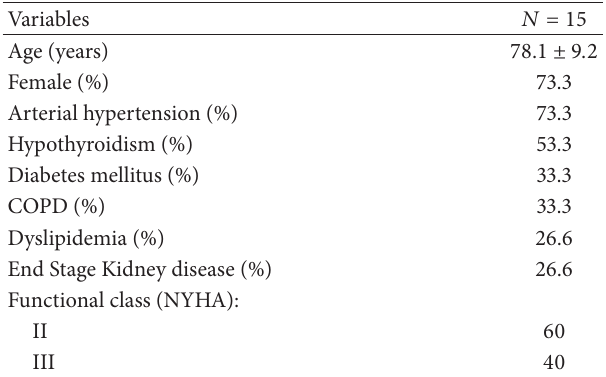
Table 1: Demographic and clinical characteristics of the CHF